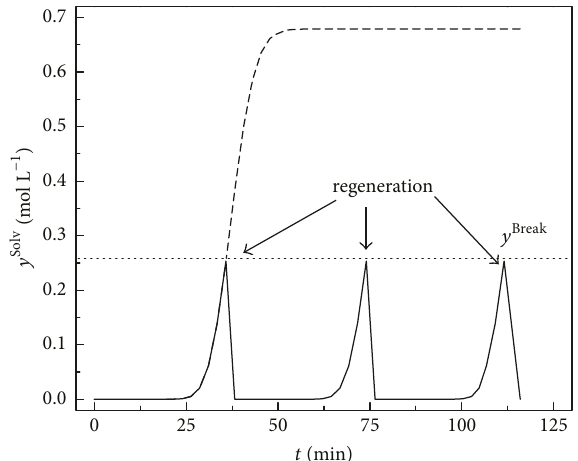
Figure 2: SLA unit operated to saturation (dashed line) or in cyclic mode with intermediate regeneration (solid line). Impurity concentration in the fluid phase at the adsorption column outlet, 𝑦 Solv , as a function of time. Continuous operation. 𝑦 break = value of 𝑦 Solv at regeneration